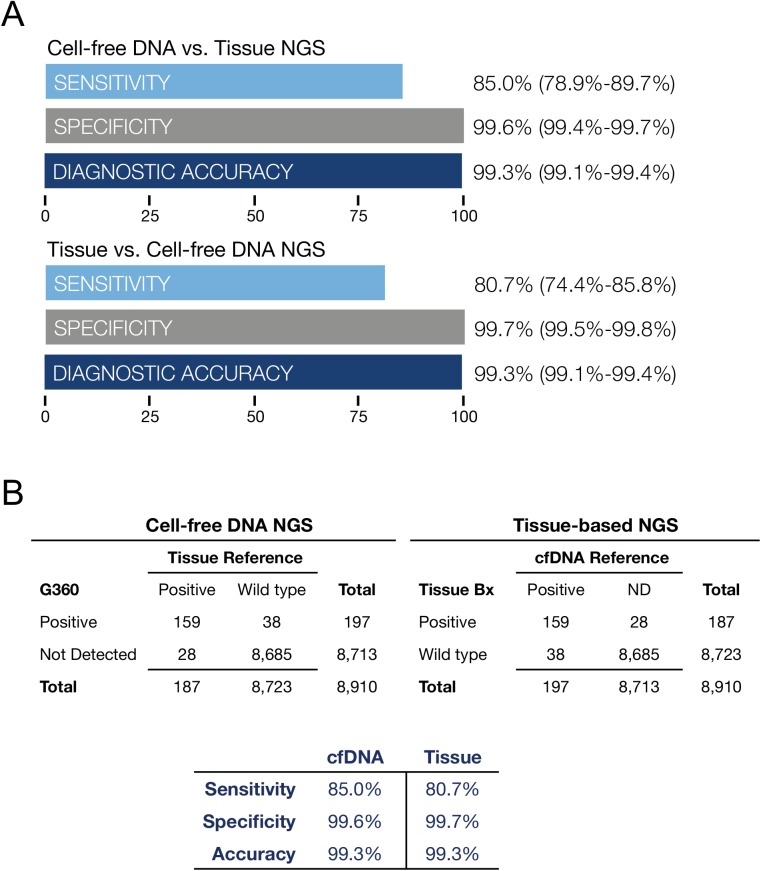
Fig 7A is a comparison of tissue NGS results biopsied at five outside institutions compared to cfDNA sequencing at Guardant Health on 165 paired plasma samples from stage III-IV solid tumor cancer patients. Data summarizes diagnostic test performance for all 54 mutated tumor suppressor and oncogenes. The most commonly mutated genes were ALK, APC, BRAF, CDKN2A, CTNNB1, FBXW7, KRAS, NRAS, PIK3CA, PTEN, and TP53. Sensitivity, specificity and diagnostic accuracy are shown with 95% confidence intervals.Fig 7B illustrates the two by two contingency tables corresponding to Fig 7A. On the left cfDNA NGS results are compared to tissue-based NGS as the reference standard. On the right tissue-based NGS results are compared to cfDNA findings as the reference standard. All gene mutations found in cfDNA and tissue DNA based on NGS of 54 genes are shown in S2 Table. Both methods demonstrate similarly high sensitivity and near-perfect specificity. For cfDNA, sensitivity is limited by the amount of tumor DNA shed into circulation and for tissue, sensitivity is likely limited by sampling error related to intra-or inter-tumor heterogeneity. The sampling error on tissue samples may be related to sub-sampling of tumor heterogeneity by needle or surgical biopsy.